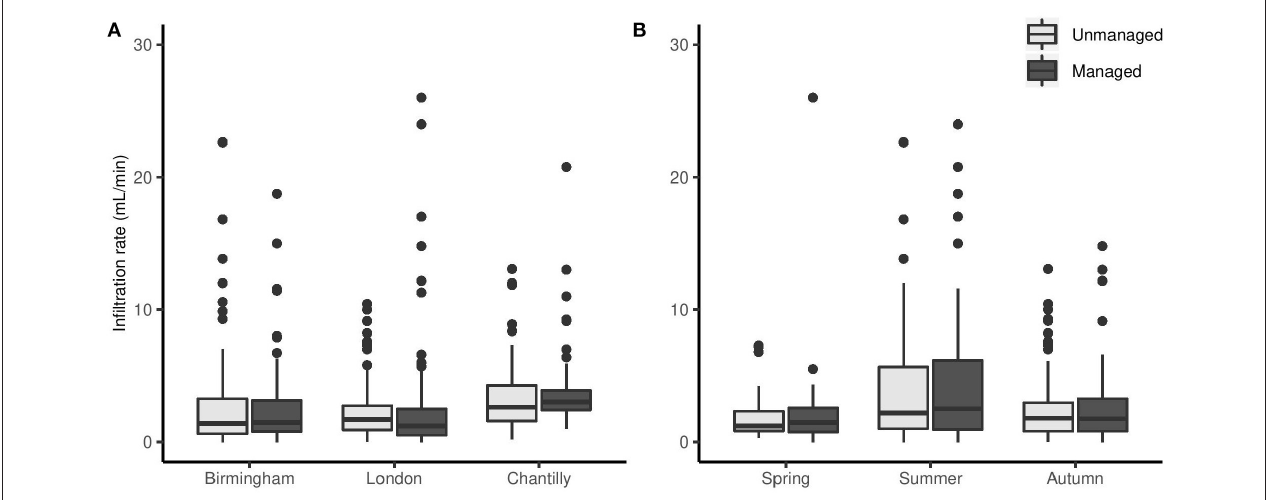
FIGURE 1 | Boxplots of raw infiltration rate (mL/min) transformed to positive values, according to management regime (gray = unmanaged; black = managed), by (A) location of park where samples were taken, and (B) season. Central horizontal line in boxplot = median; box limits = first and third quartiles; whiskers = 1.5 times the interquartile range. Data beyond the whiskers plotted as outliers, with points > 30 mL/min not